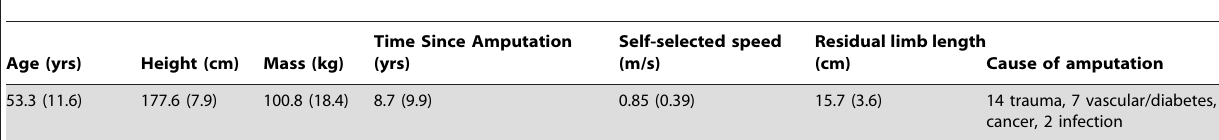
Table 1. Subject demographics. Note all participants were MFCL K3 or K4 level